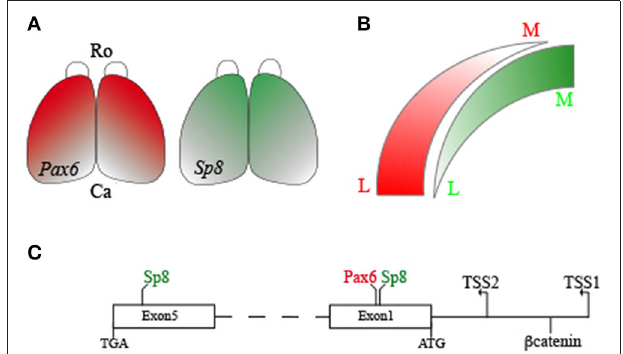
FIGURE 7 | Schema of the SP8, PAX6, and β catenin interactions on the mouse Ccnd1 gene. Panel (A) shows Sp8 and Pax6 expression gradients in the developing mouse cortex. Panel (B) summarizes differences in Sp8 and Pax6 expression levels along the medio-lateral axis of the pallium. Panel (C) is a graphical representation of SP8, PAX6, and β catenin binding positions on Ccnd1 locus. R, Rostral; C, Caudal; M, Medial; L,